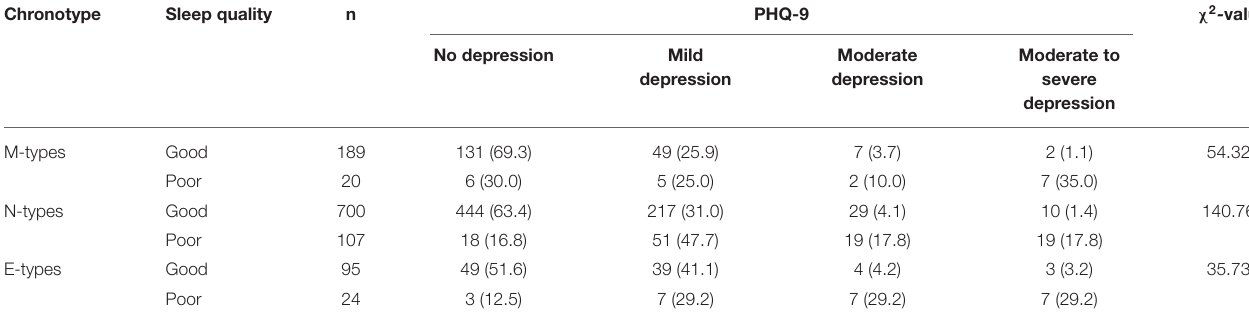
TABLE 3 | Associations of chronotype, sleep quality and depressive symptoms in college students.